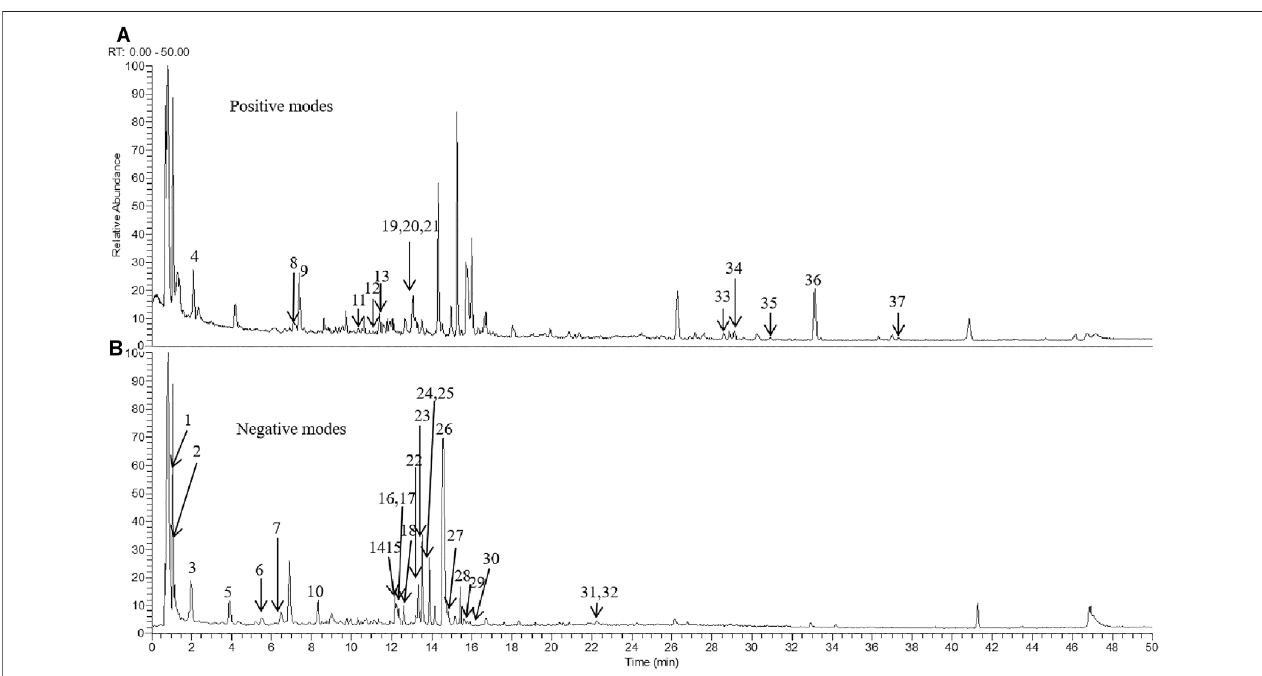
FIGURE 1 | TLYS samples were examined by UHPLC – MS. Total ion chromatography in positive (A) and negative (B) ion modes for TLYS samples are shown.